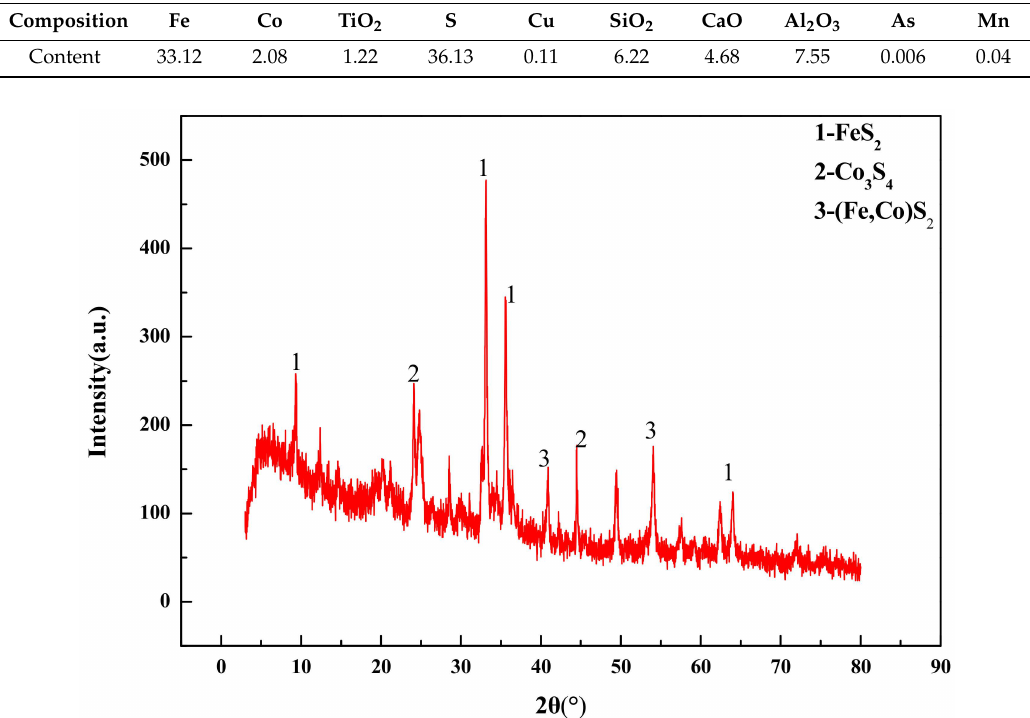
Table 8. Main chemical composition analysis of cobalt–sulfur concentrate (%).